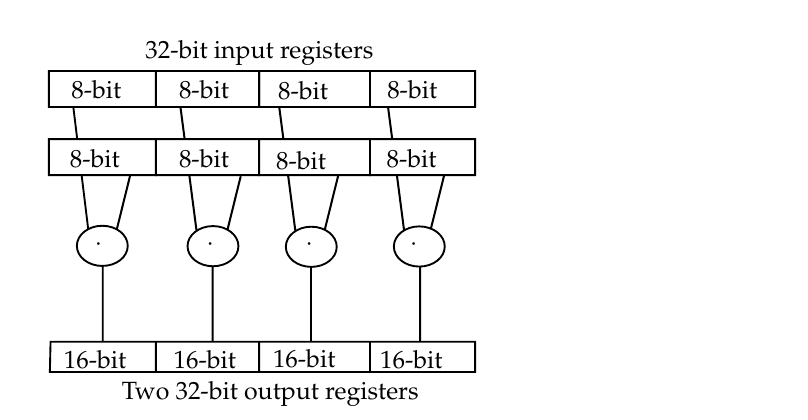
Figure 5. The SMUL8 instruction as an example of the SIMD instructions in the p-extension of the RISC-V ISA [25]. Eight 8-bit input values are accessed in two 32-bit words, multiplied and saved in four 16-Bit values in the 64-bit result.